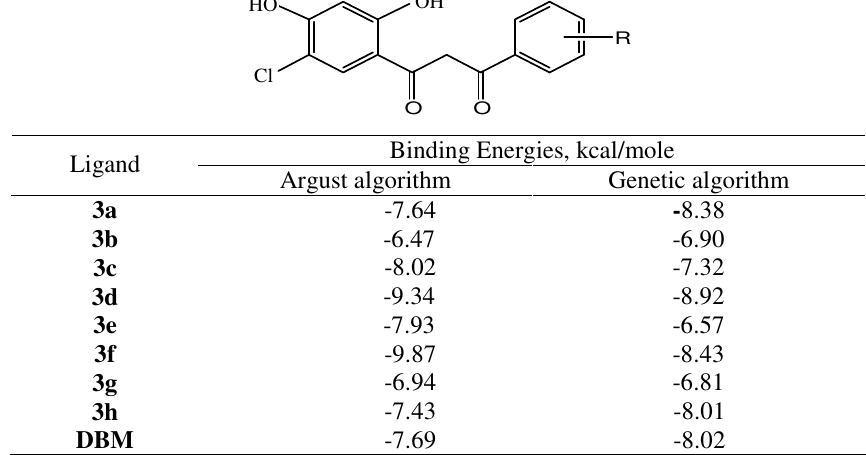
Table 1. Docking analysis of 1-(2', 4'-diydroxy-5'-chlorophenyl)-3-aryl-propane-1, 3-diones ( 3a-h ) with cytochrome P450 reductase showing binding free energies OHO OH R Cl O Binding Energies, kcal/mole Ligand Argust algorithm Genetic